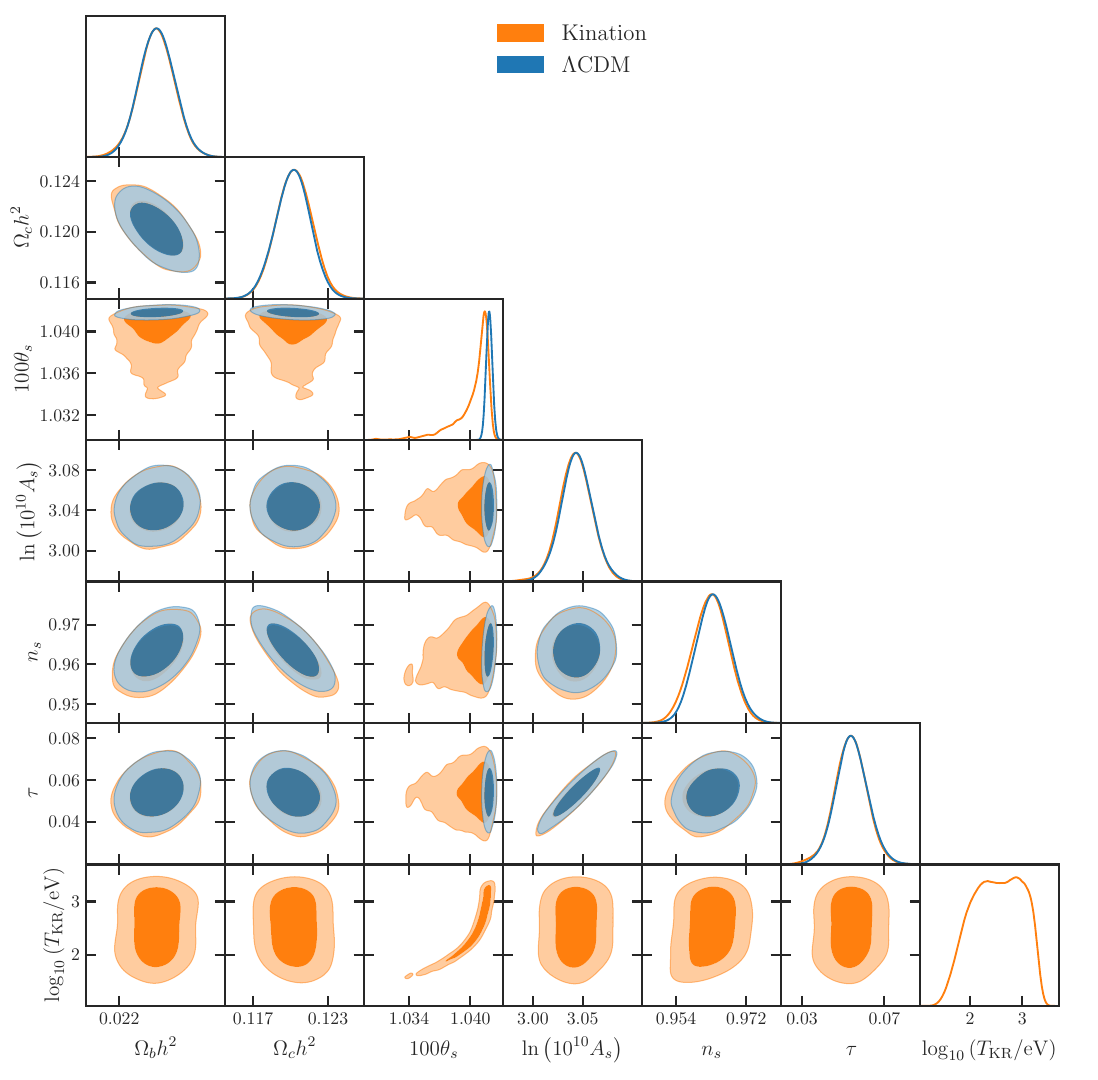
Figure 16 . Corner plot for the posterior distributions for the Λ CDM independent parameters and for the axion kination model. We use the highTTTEEE+lowEE+lowTT likelihood combination from Planck 2018. Contours contain 68% and 95% of the